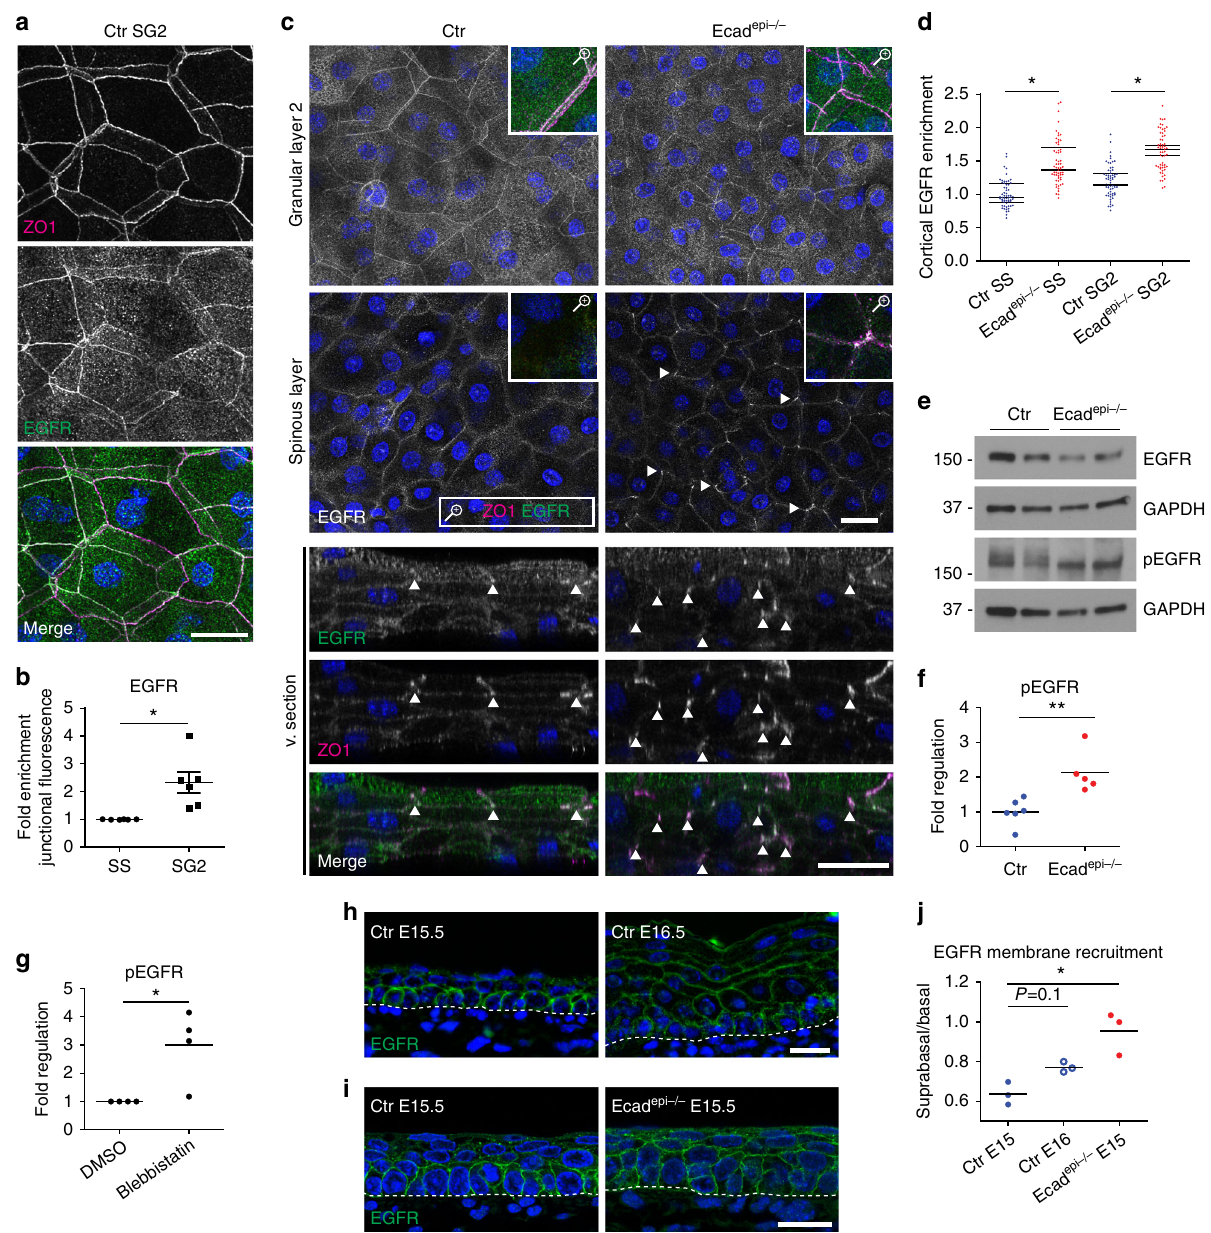
Fig. 7 E-cadherin regulates EGFR tissue polarization and activity. a Newborn epidermal whole-mount fl uorescence analysis for EGFR and ZO-1 showing enrichment of EGFR at TJs in control SG2 layer. b Quanti fi cation of junctional EGFR fl uorescence intensity. n = 6 biological replicates with 10 junctions each. Graph shows mean values ± SEM and single means of biological replicates (dots/squares). Granular layer (SG) intensity was normalized to spinous layer (SS) intensity. * P = 0.0214 with D ’ Agostino & Pearson omnibus normality test followed by one sample t -test. c Newborn epidermal whole-mount fl uorescence analysis for EGFR and ZO-1 showing SG2, SS, and cross section (v. section), showing increased junctional ZO-1 and EGFR (arrowheads) in the SS of E-cadherin (Ecad) − / − epidermis compared to control (Ctr). a , c Partial projections and v. sections of confocal stacks from newborn epidermal whole mounts. For better visualization fl uorescence intensities of SS projections have been increased relative to SG. Nuclei were stained with DAPI (blue). d Quanti fi cation of cortical EGFR enrichment in SG normalized to Ctr SS. Shown are respective means (lines) of three biological replicates with 20 measurements (dots) per replicate, * P < 0.05; n = 3 biological replicates with Kruskal – Wallis, Dunn ’ s post hoc test. e Western blot for total and phosphorylated EGFR (pEGFR) from Ctr and Ecad epi − / − newborn epidermis. f Western blot quanti fi cation of pEGFR levels in newborn Ctr and Ecad epi − / − epidermis. ** P = 0.0042; Ctr n = 6, Ecad epi − / − n = 5 biological replicates with Student ’ s t -test. g Quanti fi cation of western blot for phospho-EGFR (72 h in high Ca 2+ , blebbistatin added after 24 h). * P < 0.05; n = 4 biological replicates with one sample t -test, hypothetical value = 1 (normalized to control treated DMSO). h Staining of embryonic skin for EGFR before (E15.5) and after epidermal barrier formation (E16.5, dorsal skin). i Immuno fl uoresence analysis of E15.5 control and Ecad epi − / − skin for EGFR shows premature suprabasal localization of EGFR. Nuclei were stained with DAPI (blue). j Quanti fi cation of cell membrane EGFR intensities (mean gray value) in suprabasal vs. basal layers. The ratio of suprabasal vs. basal layer membrane intensity is plotted. Dots represent means of biological replicates. * P < 0.05; n = 3 biological replicates each group with Kruskal – Wallis, Dunn ’ s post hoc test. Scale bars, 20 µ